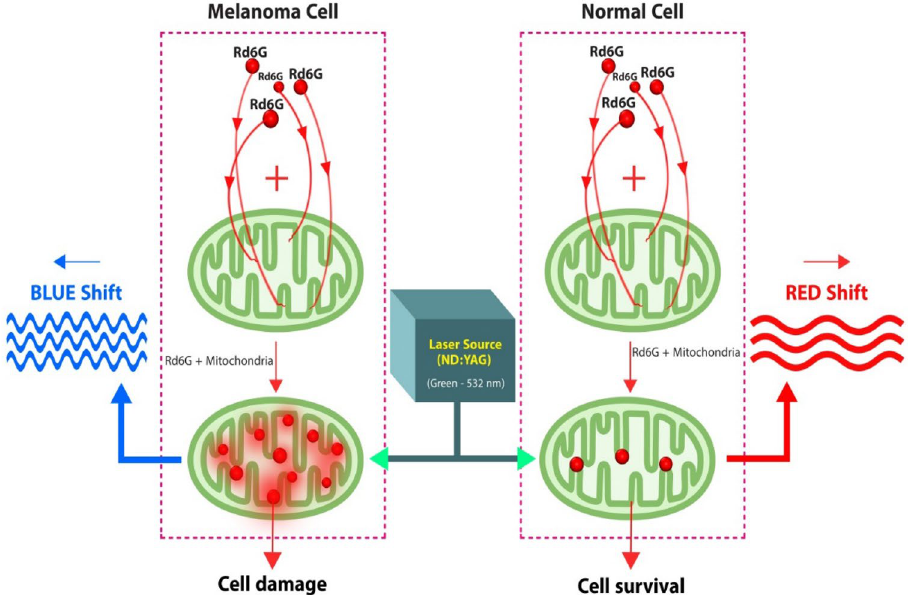
Figure 3. A conceptual model based on the graphical representation of (Rd6G + mitochondria) in melanoma and normal cells. After laser excitation, the stained melanoma undergoes a lucid blue shift, while the fluorescence emission of normal cells reveals redshift events. This key optical discrepancy is used to discriminate different lesions. Furthermore, unhealthy cells are most likely demolished after Rd6G exposure to mitochondria based on their ample conjugation and bindings, whereas normal cells survive due to low chemical affinity. This conceptual model is verified by virtue of statistical processing given in Supplementary (“Statistical analysis”